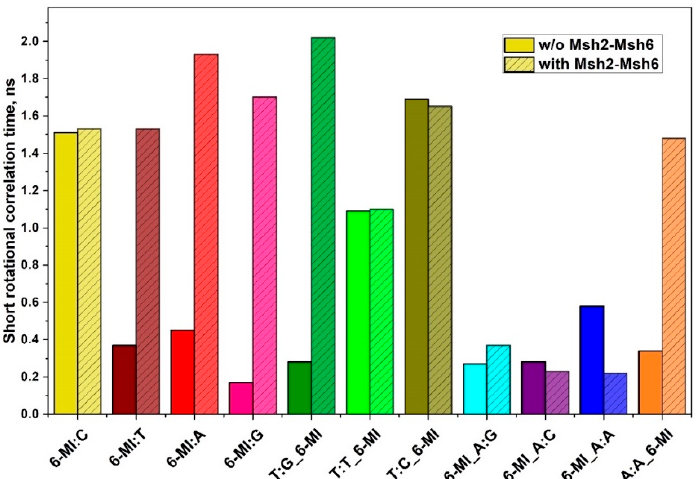
Figure 4. Time-resolved anisotropy decays of 6-MI-containing duplexes with and without Msh2–Msh6. A faster rotational correlation time corresponding to local motion ( θ L ) is observed in the Msh2–Msh6 high affinity substrates without protein (solid bars). Upon Msh2–Msh6 binding, an increase in θ L for 6-MI at a mismatched bp or in the T:G_6-MI and A:A_6-MI substrates is attributed to local stabilization of the probe. No changes upon protein binding are observed in the 6-MI:C, T:T_6-MI and T:C_6-MI substrates. Data were collected and analyzed as described in the text.